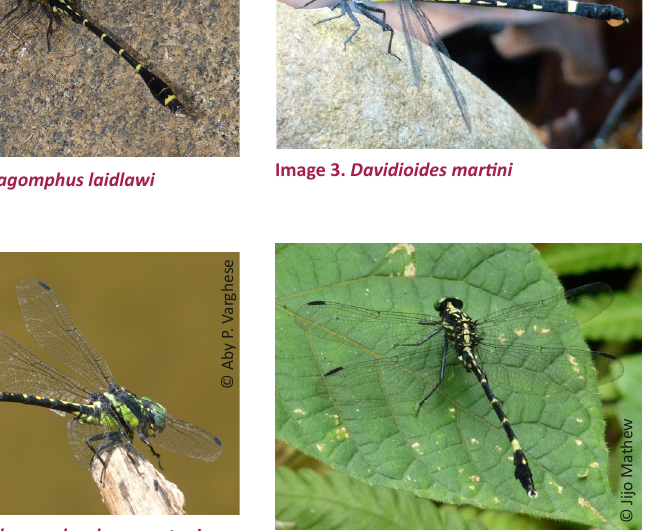
Image 6. Merogomphus longistigma